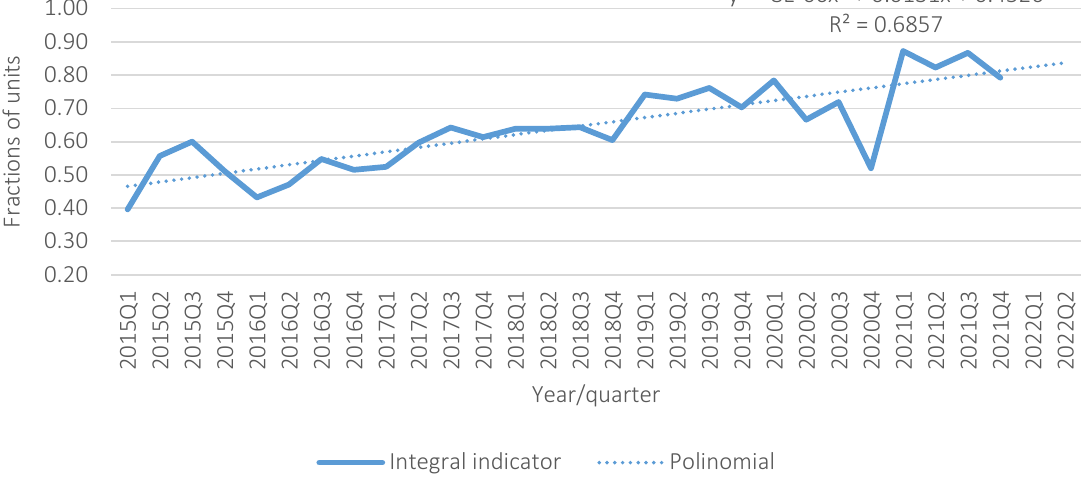
y = -8E-06x 2 + 0.0131x + 0.4526 R² =